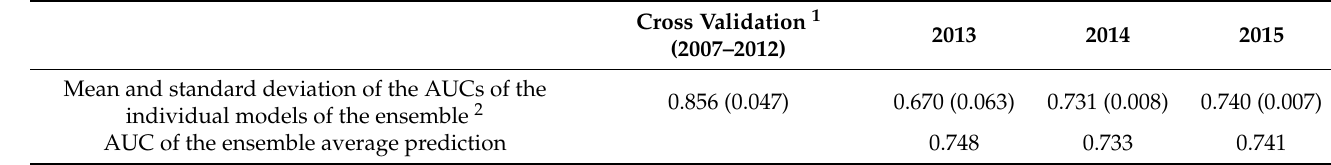
Figure 2. Coefficients assigned by the ensemble models to the mostly used features (i.e., features used by at least half of the models). Table 3. Prediction performance of the regularized logistic regression in cross validation and on the test dataset. The area under the receiver operating curve (AUC) represents the probability that, given two random cells, one established and one non-established, the classifier assigns a larger risk of establishment to the established